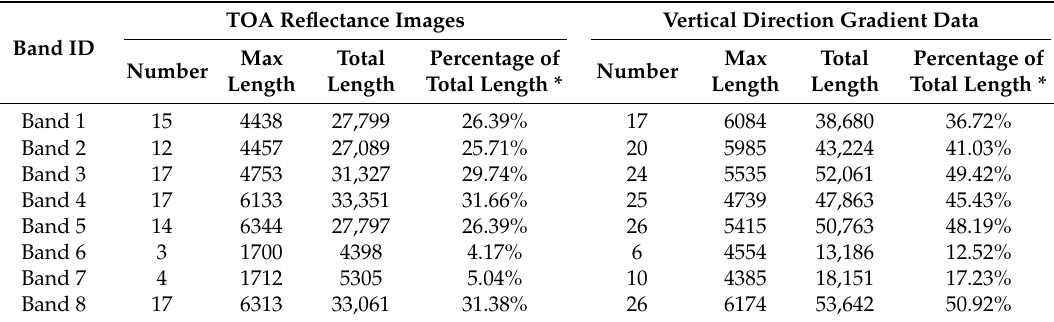
Table 3. The statistics of the detected tidal cracks with lengths greater than 1000 m from the TOA reflectance images and vertical direction gradient data with resolutions of 15 m.